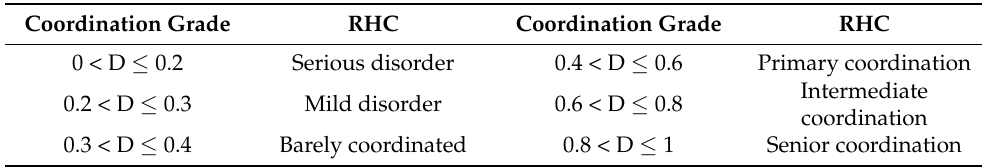
Table 2. Evaluation standard of coordination